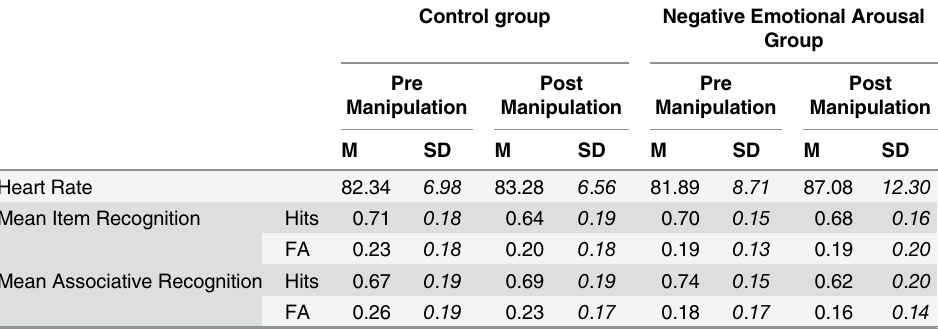
Table 2. Heart-Rate and Memory Performance in the Pre and Post Manipulation Phases for the nega- tive emotional arousal and Control Groups. Control group